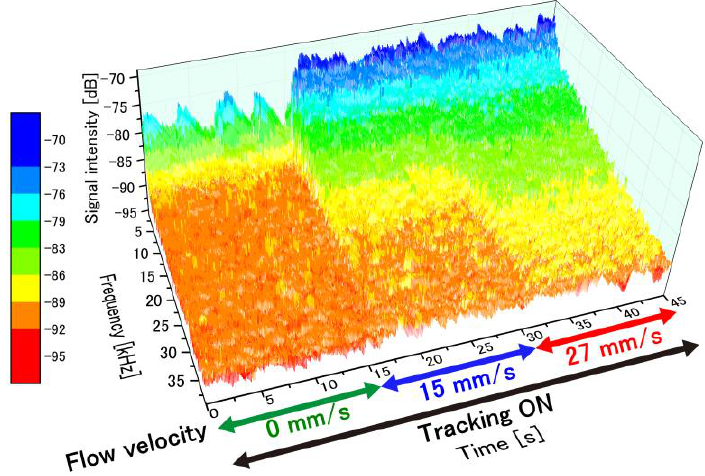
Figure 9. Perfusion spectra changing in time during the entire measurement period (45 s). Flow velocity was controlled at three different flow velocities (0 mm/s from 0–15 s, 15 mm/s from 15–30 s, and 27 mm/s from 30–45 s).